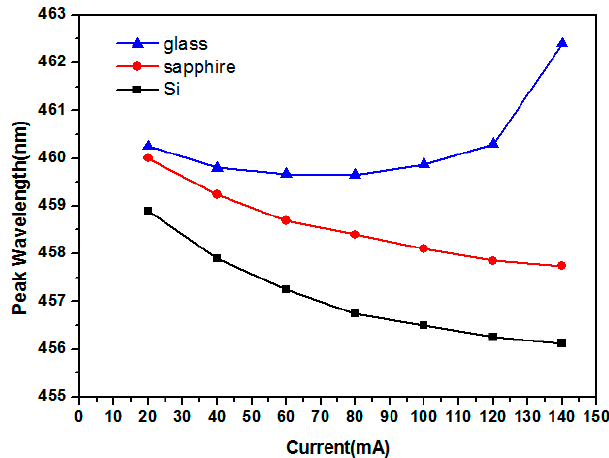
Figure 4. Peak wavelength variation vs. operation current for LEDs mounted on different